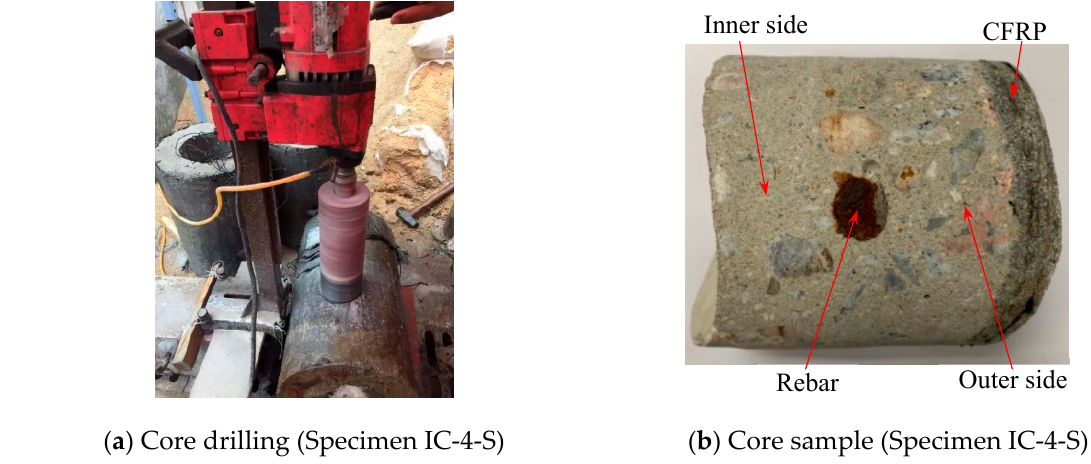
Figure 9. Drilling process and the core sample.